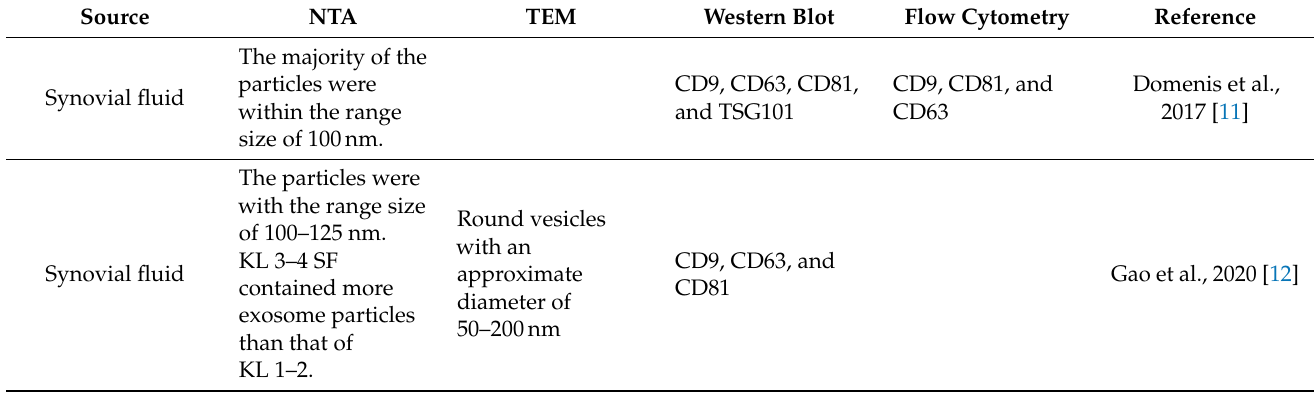
Table 1. Characterization methods of OA-specific